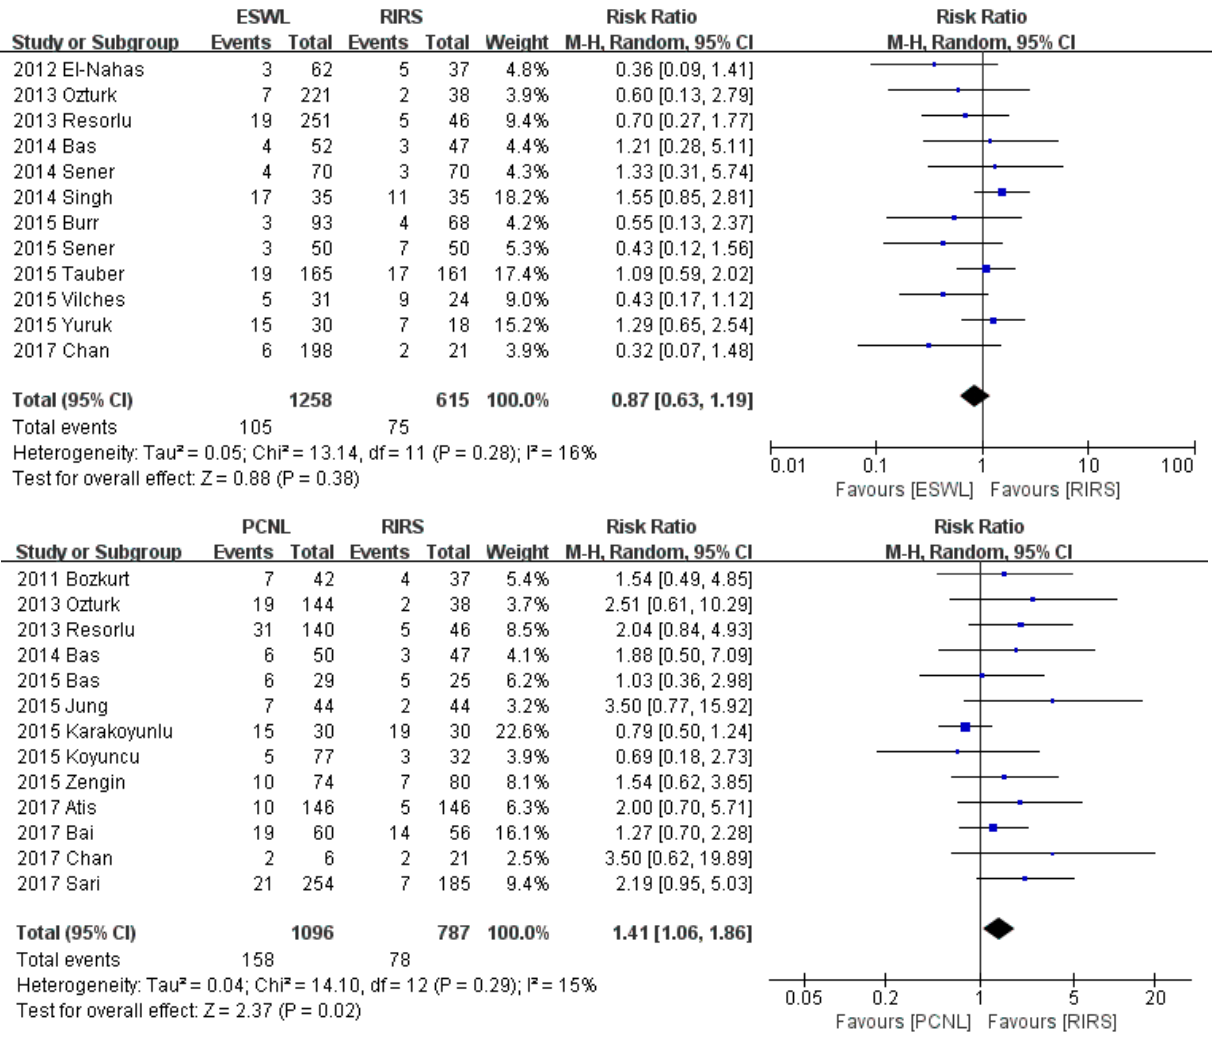
Figure 5. Meta-analysis of total complications: ( a ) ESWL vs. PCNL; ( b ) ESWL vs. RIRS; and ( c ) PCNL vs. RIRS. Sub-group analysis was conducted on the criterion of 2-cm stone diameter. A com- parison of SFRs is shown in Figure 6. In the group of stones smaller than 2 cm, like in the primary analysis, ESWL resulted in fewer complications than PCNL ( p < 0.001; RR = 0.29; 95% CI, 0.16–0.52; I 2 = 40%), whereas no statistically significant difference was found between ESWL and RIRS ( p = 0.26; RR = 0.81; 95% CI, 0.56–1.17; I 2 = 22%). RIRS resulted in fewer complications than PCNL ( p = 0.009; RR = 2.05; 95% CI, 1.20–3.52; I 2 = 0%). In the group of stones larger than 2 cm, unlike in the primary analysis, no significant difference was noted between PCNL and RIRS ( p = 0.29; RR = 1.24; 95% CI, 0.84–1.83; I 2 = 35%). No studies compared PCNL and ESWL or RIRS and ESWL.